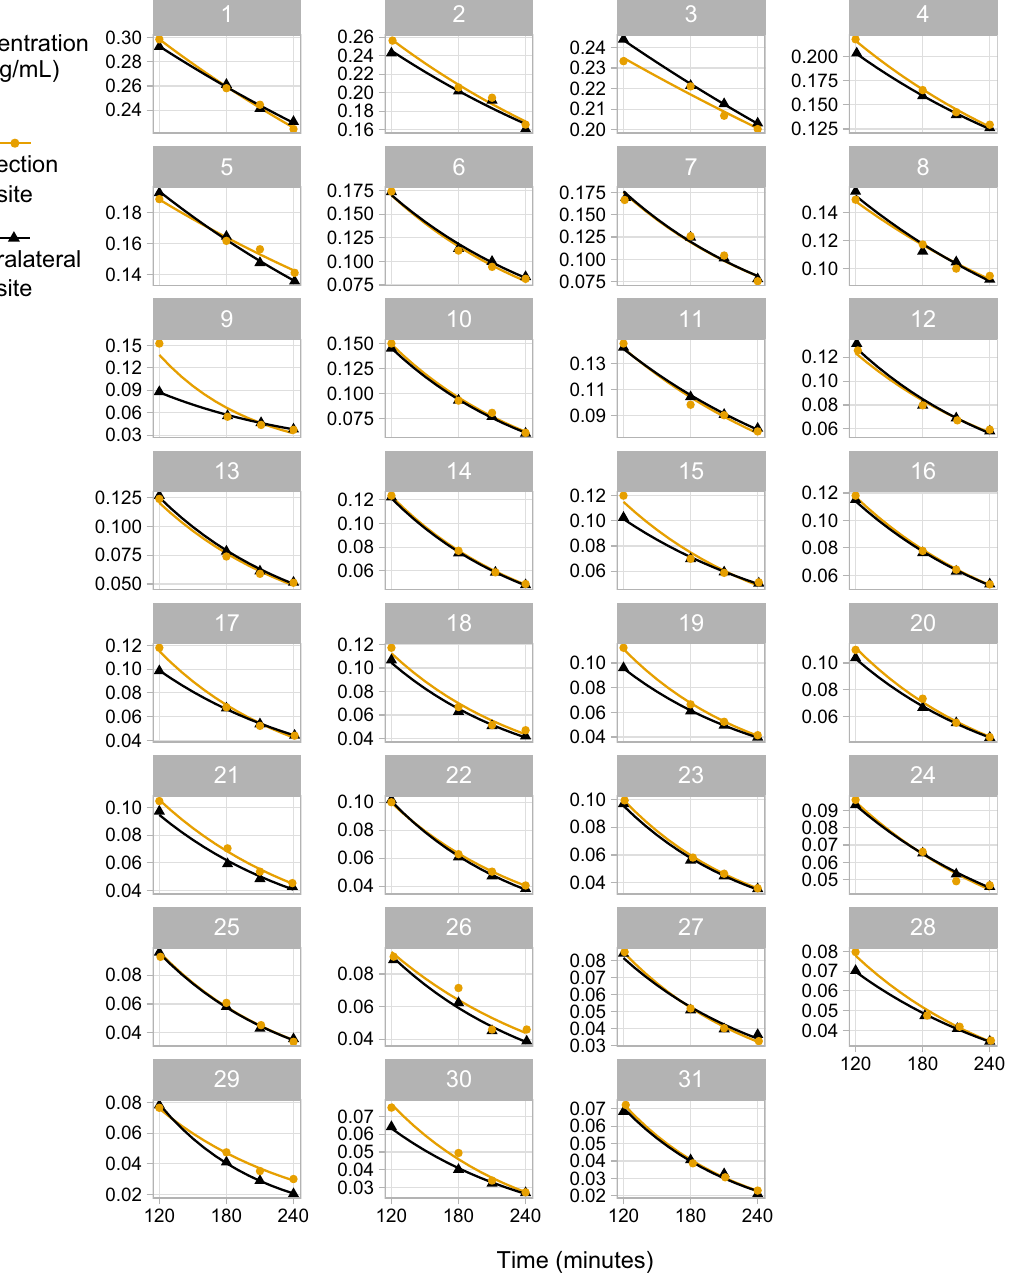
Figure 1. Measured iohexol concentration levels for both arms for the four time points, along with fitted concentration curves based on Jødal–Brøchner-Mortensen’s formula 26,27 . The model showing more similar values at 3.5 and 4 h time points for most of the